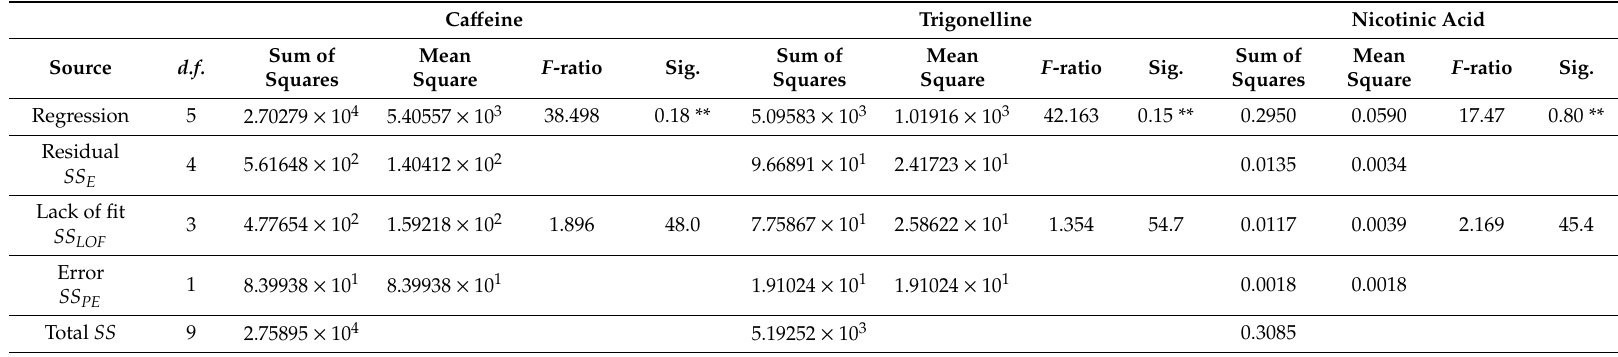
Table 4. ANOVA for the quadratic experimental models for ca ff eine, trigonelline, and nicotinic acid, along with the significant values, where the symbol * stands for a p -value ( p ) ≤ 0.05, ** for p ≤ 0.01, and *** for p ≤ 0.001.